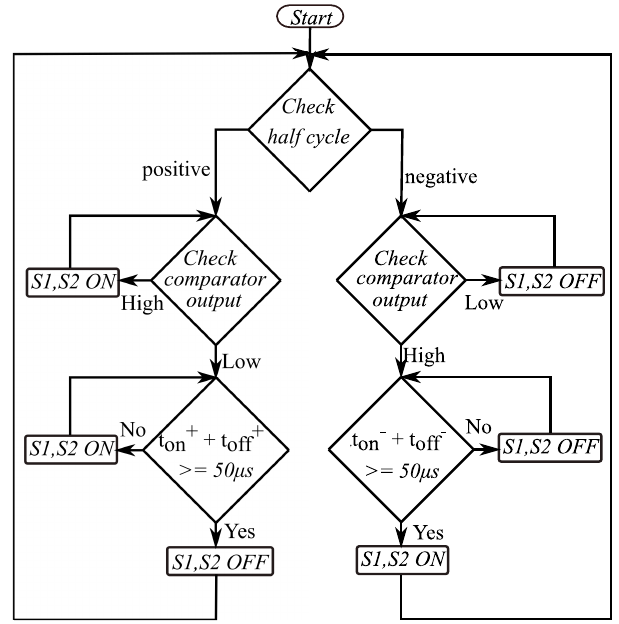
Figure 2. Control algorithm of the proposed